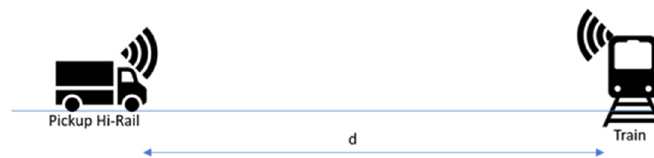
Figure 9. Train–Hi-Rail pickup (LOS).